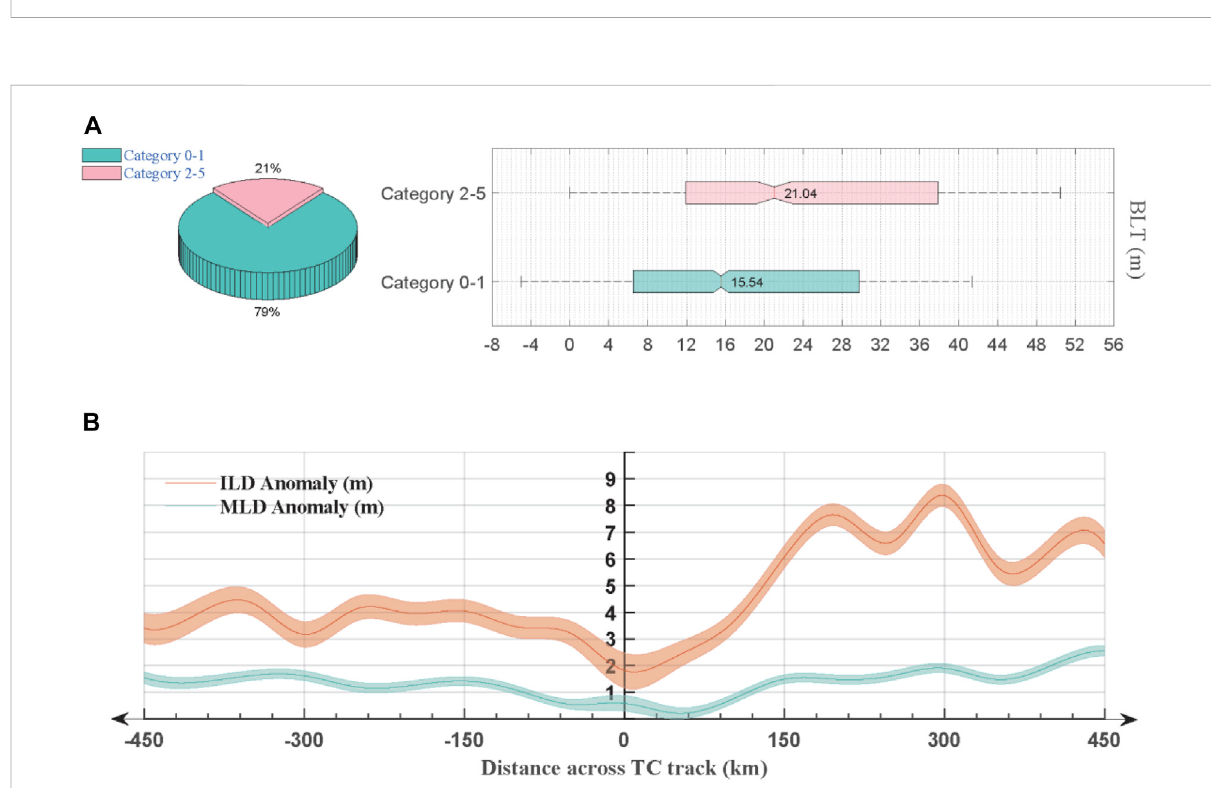
Thepiechart(left)in (A) showsthepercentageofArgopro fi lesizewithin200 kmaroundthebesttrackrecordingpoint(totalpro fi lesize:2801). The boxplot (right) in (A) represents the relationship between the BLT and the intensity of TCs. The difference between the two adjacent groups is statistically signi fi cant above the 99% con fi dence level based on the Student ’ s t -test. The changes of ILD anomaly(red) and MLD anomaly (green) by Argo data within 450 km across the TC track are shown in (B) . The result in the fi gure is calculated by subtracting the average value of 5 – 7 days before TC came from the average value within 10 days after TC left. The solid line in the (B) represents the average value and the shaded areas represent standard errors which are calculated as the standard deviation divided by the square root of each sample